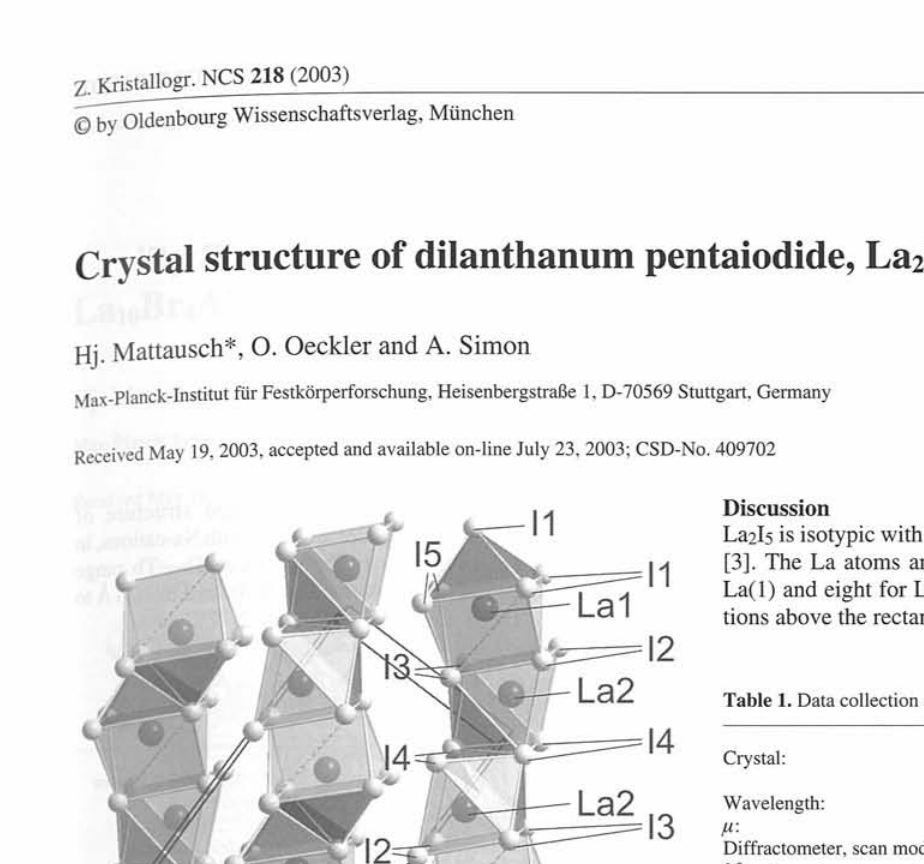
Table 1. Data collection and handling.